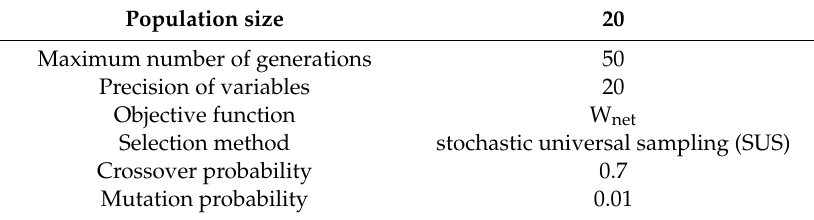
Figure 4. Flow chart of genetic algorithm method scheme. Table 2. Configurations of genetic algorithms in this